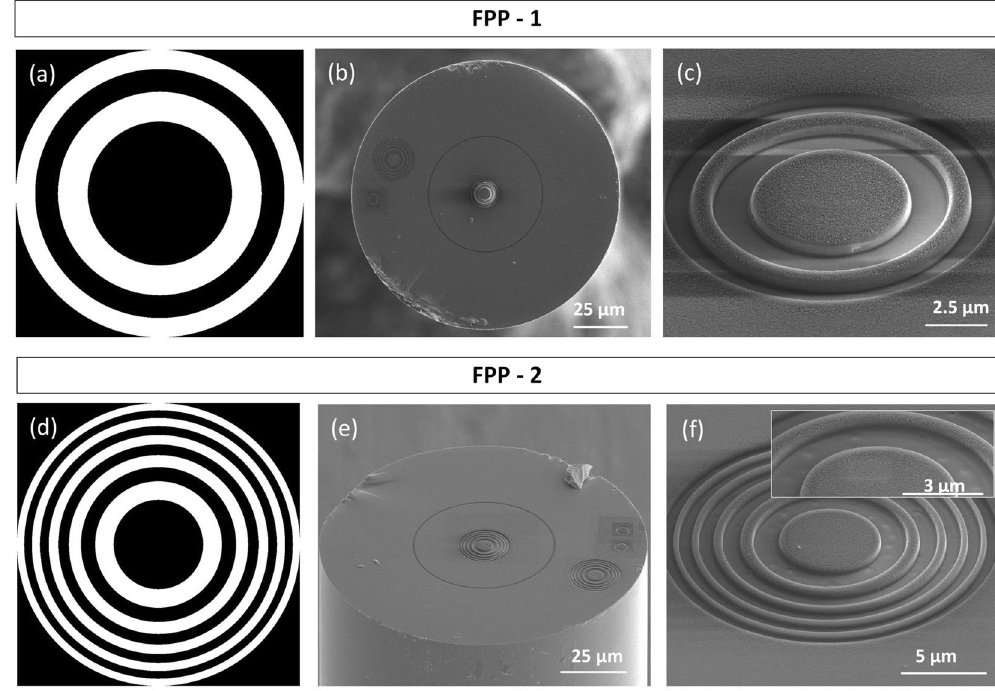
Figure 3. Fresnel phase plates: ( a ) amplitude mask used to fabricate FPP-1; ( b ) image of the optical fibre with FPP-1; ( c ) zoom of FPP-1; ( d ) amplitude mask used to fabricate FPP-2; ( e ) image of the optical fibre with FPP-2; ( f ) zoom of FPP-2, (inset) details of the first three zones of